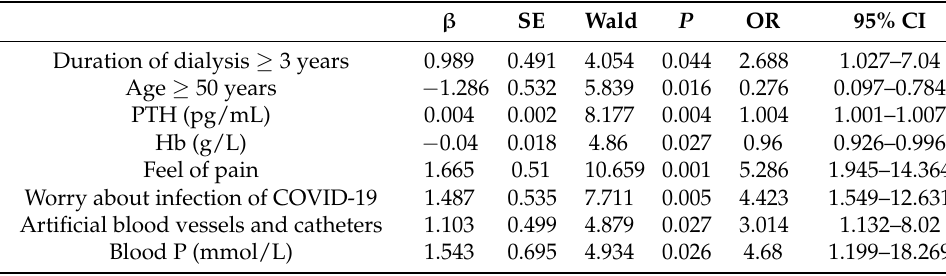
Table A3. Logistic analysis of risk factors of depression in the MHD